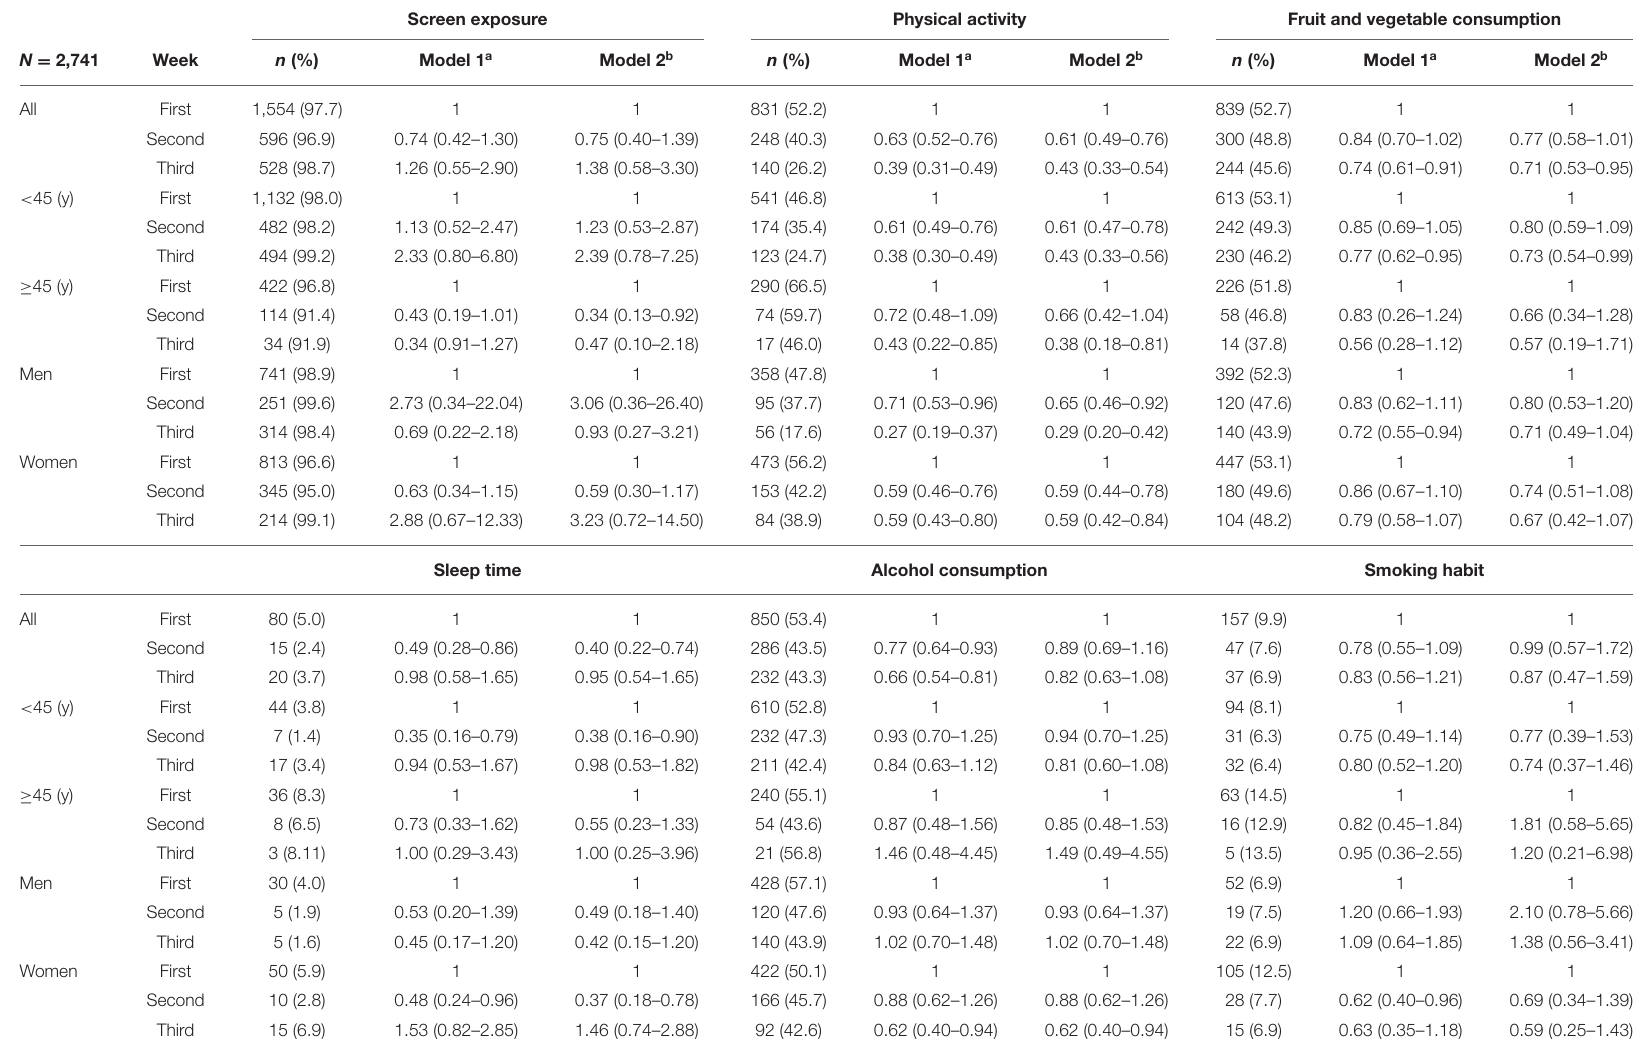
TABLE 4 | Adjusted odds ratios (95% confidence interval) for each health risk behavior during COVID-19 confinement in the entire study population and age and gender subgroups (reference group: first week of confinement). Screen exposure Physical activity Fruit and vegetable